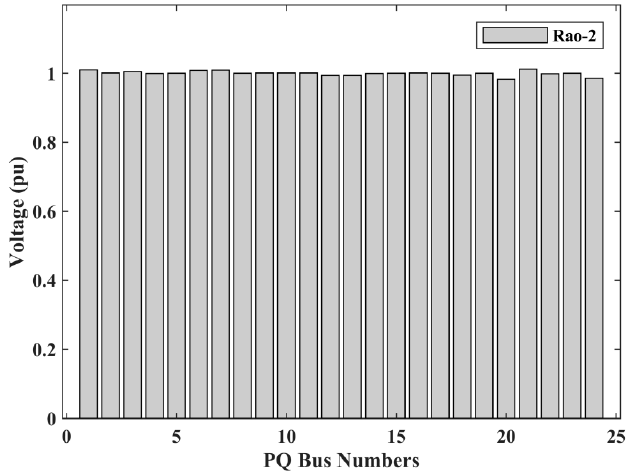
Figure 3. Load bus voltage profile for the IEEE 30-bus system, Case